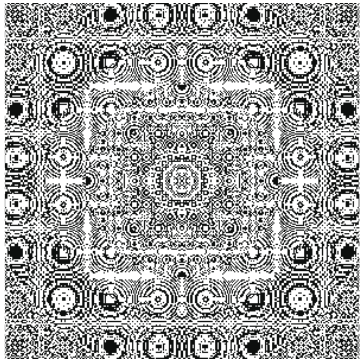
Figure 9. Downsampling of the aliasing image (a) in Figure